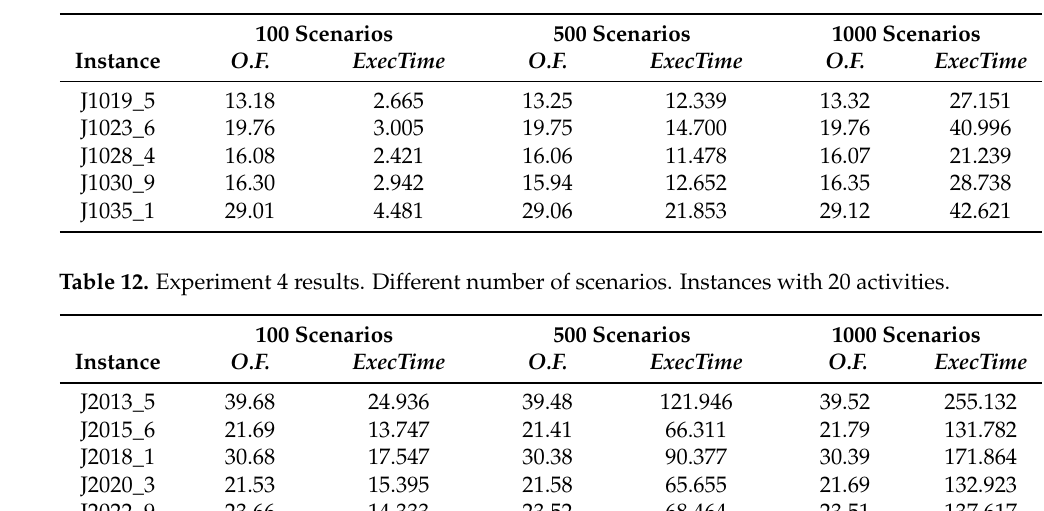
Table 11. Experiment 4 results. Different number of scenarios. Instances with 10 activities.